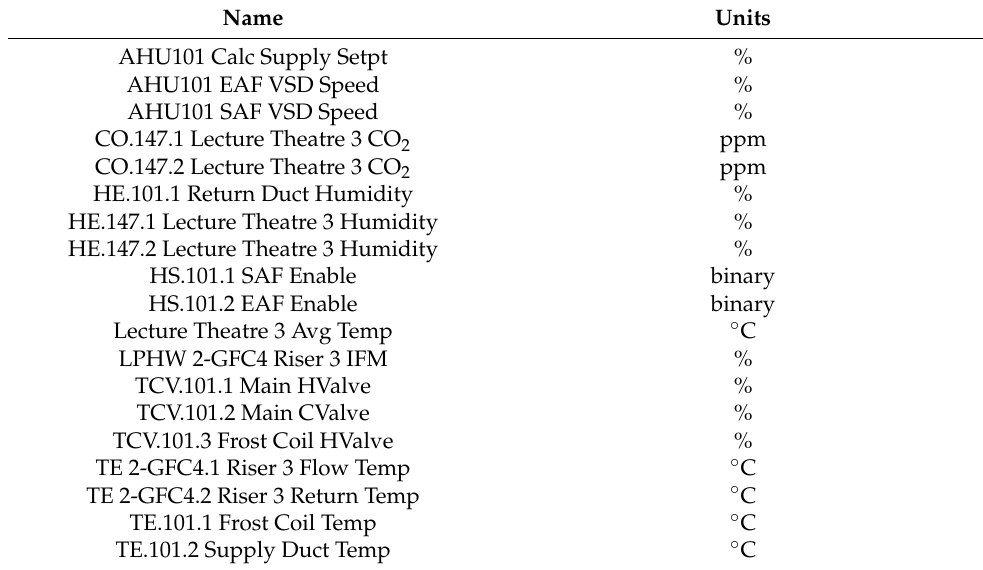
Table 1. Table listing all the variables.